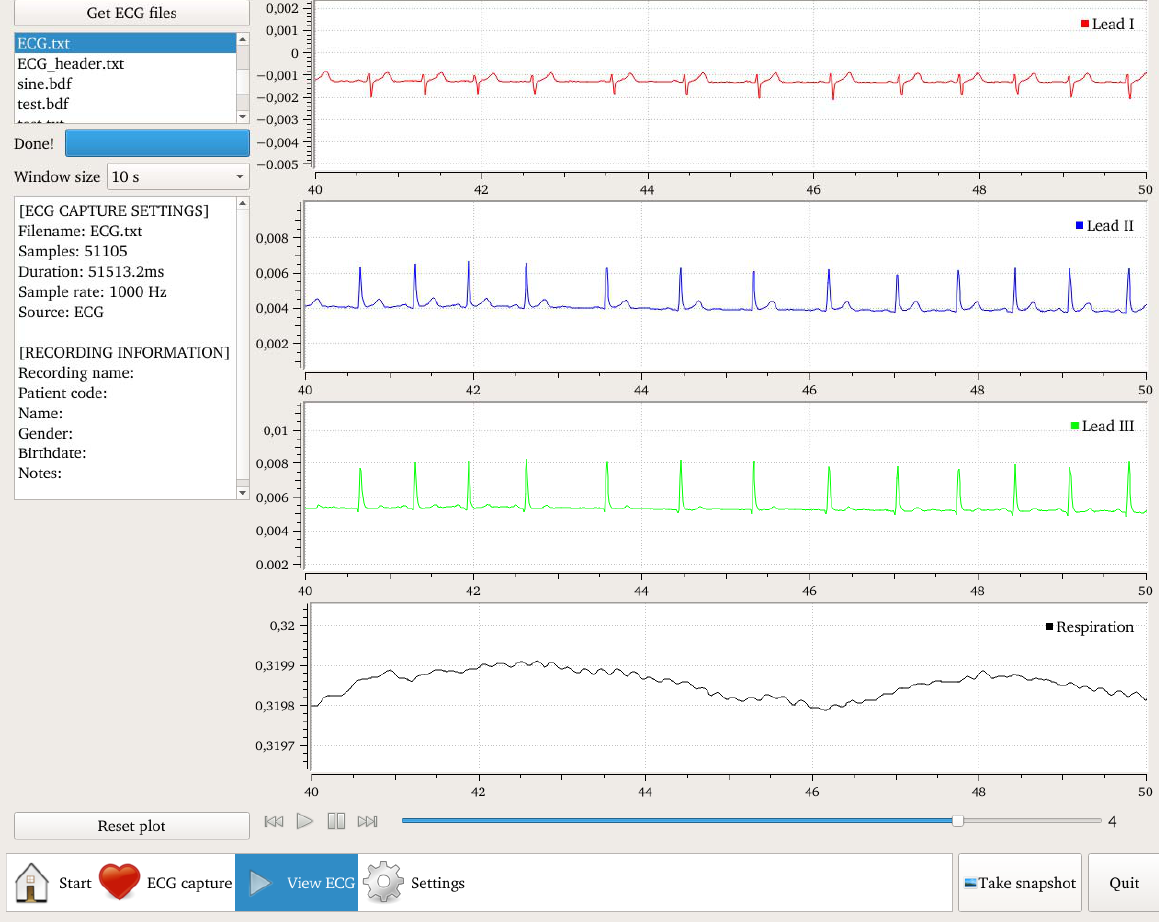
Figure 6. Screenshot of a recorded 3-leads ECG